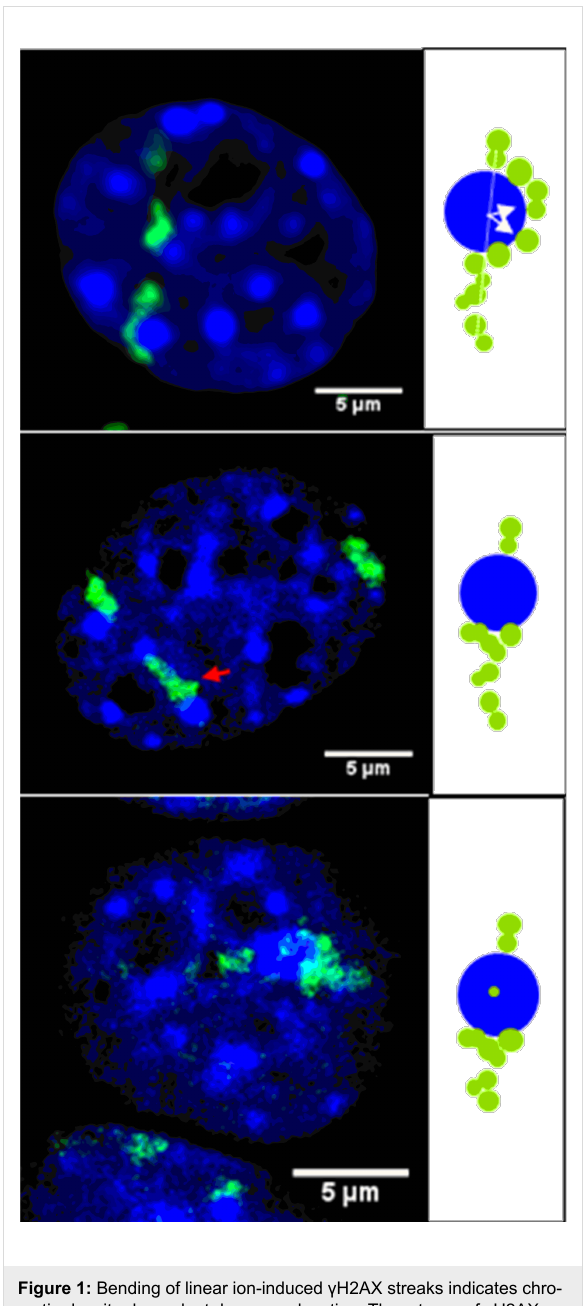
Figure 1: Bending of linear ion-induced γ H2AX streaks indicates chro- matin density-dependent damage relocation. Three types of γ H2AX patterns, each shown in a mouse embryo fibroblast nucleus and as a schematic drawing, were observed at ion-hit chromo centers: bent streaks (upper panel), interrupted streaks (middle panel) and internal signals (lower panel). Modified from